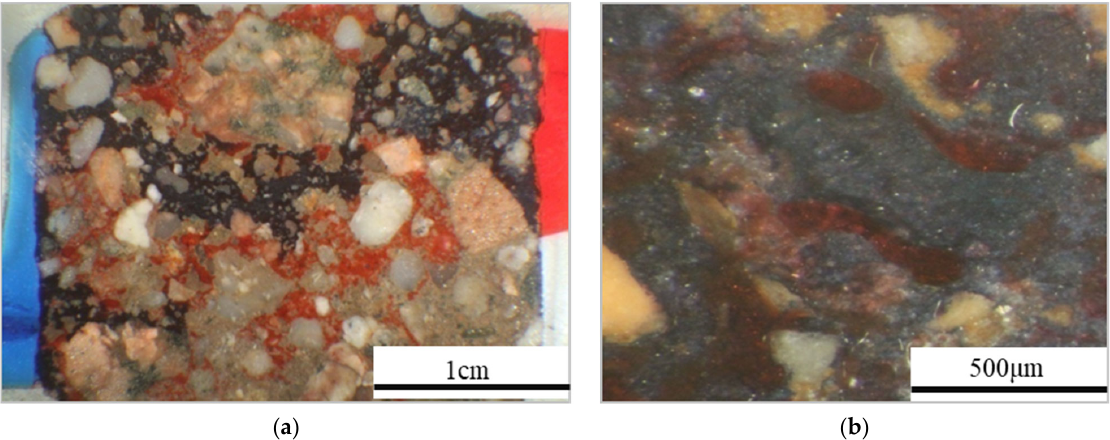
Figure 12. Distribution model of the remaining oil in the Qie12 block. ( a ) Surrounding flow remaining oil, Well Qie12 − 7 − 8, 1814.92 m; ( b ) island-shaped remaining oil, Well Qie12 − 7 − 28, 1844.12 m.